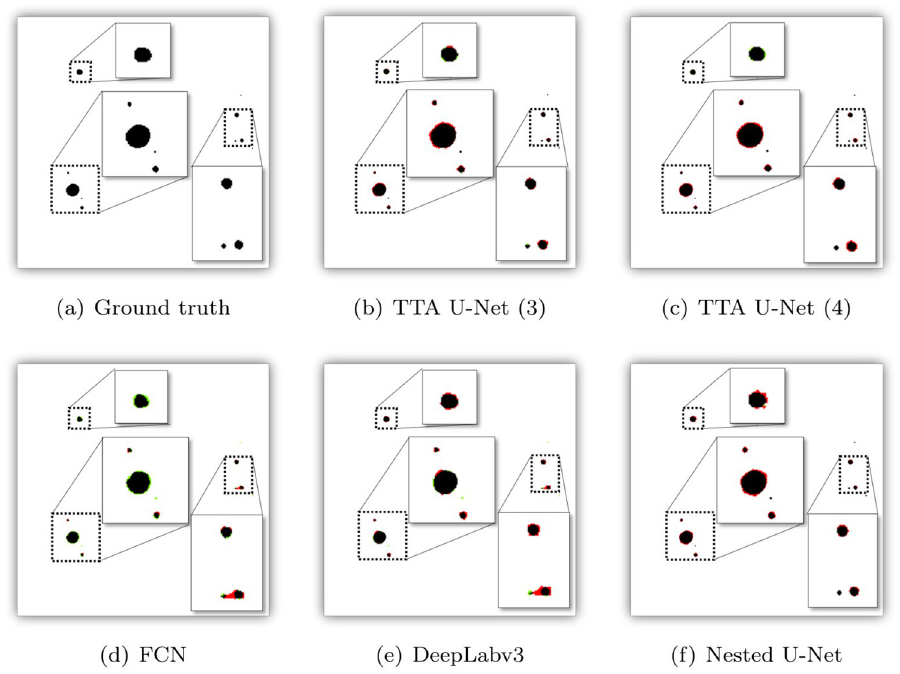
Fig 10. Visual comparison of the masks generated when making use of TTA, FCN, DeepLabv3, and Nested U-Net. For better visualization and understanding, regions with MP are also represented by making use of zoomed-in insets. Black denotes MP that has been correctly predicted (TP), red denotes predicted MP that is not MP (FP), and green denotes MP that has not been predicted as MP (FN). (a) Ground truth. (b) TTA U-Net (3). (c) TTA U-Net (4). (d) FCN. (e) DeepLabv3. (f) Nested